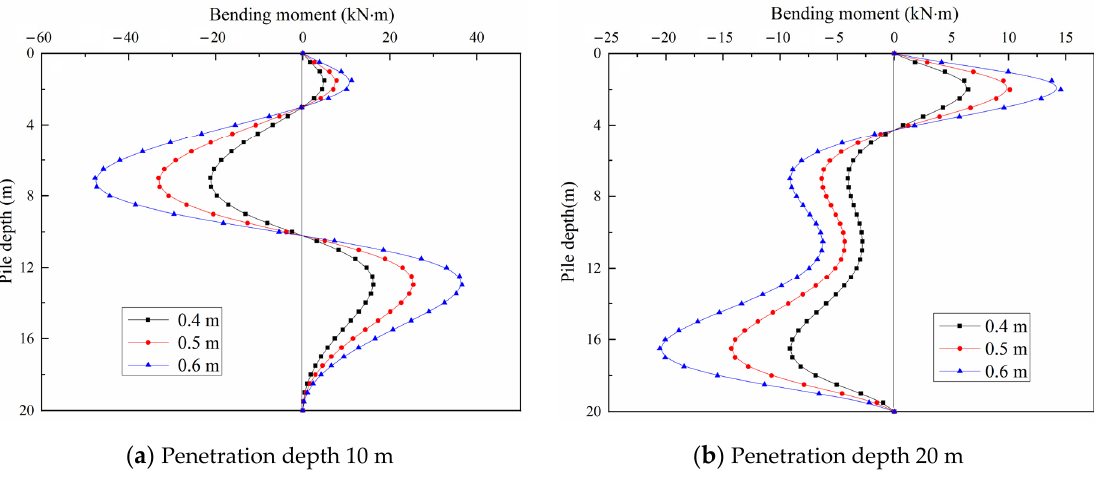
Figure 17. Influence of the diameter of the new pile on the bending moment of the used pile. Table 3. Lateral displacement variation due to diameter variation of new